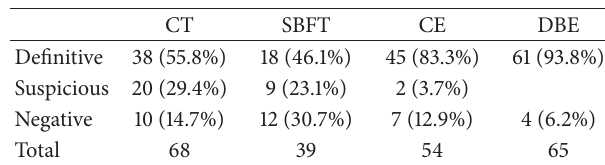
Table2:ComparisonofdiagnosticyieldsofCEandotherradiologic studies.